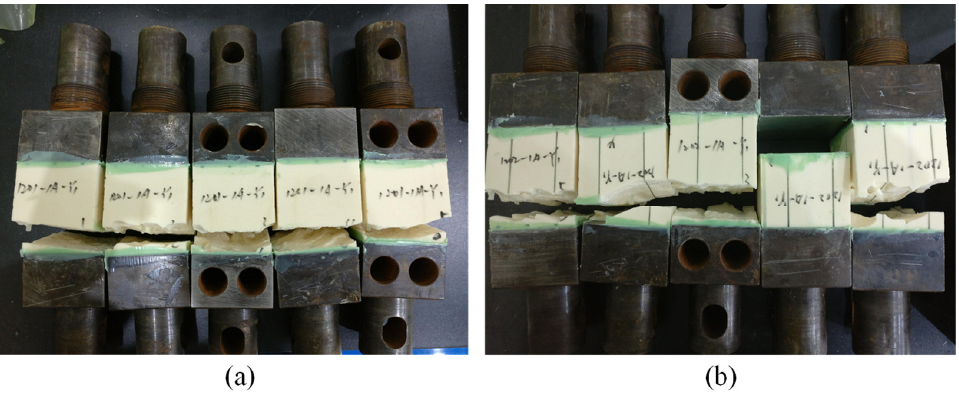
Figure 8. Failure modes of the tensile specimens: ( a ) GP core and ( b ) GPC core.